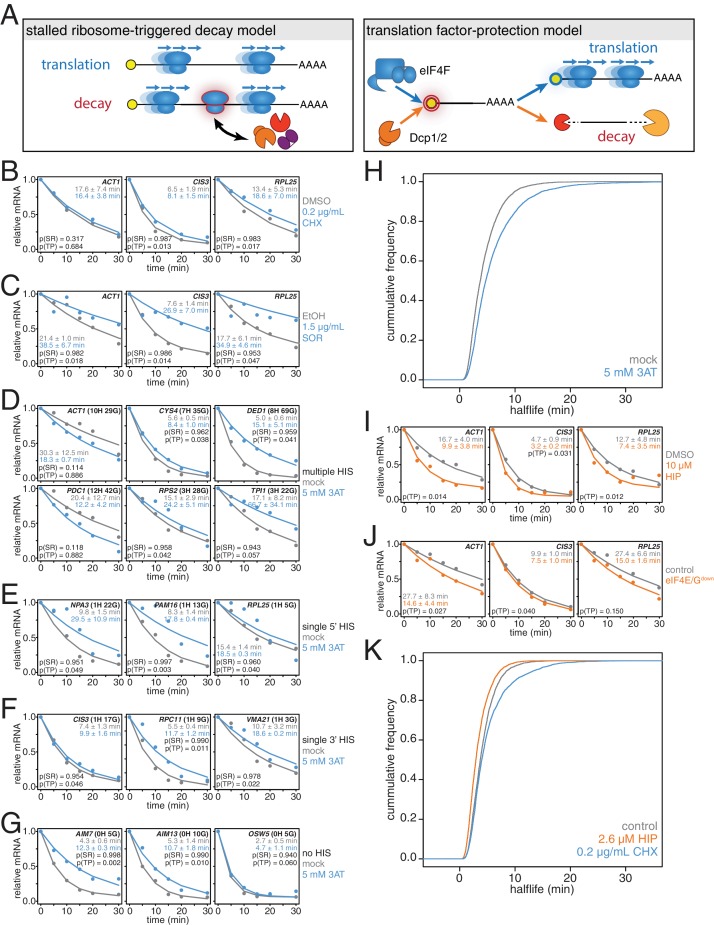
mRNAs are stabilized by slowly elongating ribosomes and destabilized when translation initiation is inhibited.(A) Cartoon depictions of the stalled ribosome-triggered decay and translation factor-protection models. (B) Wild-type cells (KWY165) were subjected to mRNA stability profiling immediately after addition of 0.1% DMSO or 0.2 μg/mL cycloheximide in 0.1% DMSO. Data on ACT1, CIS3 and RPL25 mRNAs were collected and plotted. See Figure 3—figure supplement 4A for biological replicates. P-values are computed using a one-sided paired t-test for both the stalled ribosome-triggered decay model (p(SR)) as well as the translation factor-protection model (p(TP)). P-values less than 0.05 are significant. (C) Wild-type cells (KWY165) were subjected to mRNA stability profiling 33 min after addition of 0.1% ethanol or 1.5 μg/mL sordarin in 0.1% ethanol (note that this is the timepoint when a growth defect is manifested, see Figure 3—figure supplement 1C). Data were collected, analyzed and plotted as in Figure 3B. See Figure 3—figure supplement 4B for biological replicates. (D–G) HIS3 gcn2∆ cells (KWY7337) were subjected to mRNA stability profiling immediately after non-addition (mock) or addition of 5 mM 3AT. Data were collected, analyzed and plotted as in Figure 3B. See Figure 3—figure supplement 4C for biological replicates. (H) mRNA samples collected from the experiment described in Figure 3D–G were subjected to global mRNA stability profiling. Cumulative frequencies of transcript half-life are plotted. (I) Wild-type cells (KWY165) were subjected to mRNA stability profiling immediately after addition of 0.1% DMSO or 10 μM hippuristanol. Data were collected, analyzed and plotted as in Figure 3B. p-values were not computed for the stalled ribosome-triggered decay model as this model does not make a clear prediction as to how mRNA stability is affected when translation initiation is perturbed. See Figure 3—figure supplement 5A for biological replicates. (J) pGPD1-LexA-EBD-B112 CDC33-3V5-IAA7 pRS425 cells (KWY7336: control) and pGPD1-LexA-EBD-B112 CDC33-3V5-IAA7 pGPD1-OsTIR1 pRS425-p4xLexOcyc1-CDC33∆CAP cells (KWY7334: eIF4E/Gdown) were grown in CSM-LEU-0.5xURA pH5.5 media and subjected to mRNA stability profiling immediately after addition of 10 nM β-estradiol, 100 μM 3-indoleacetic acid and 4 μM IP6. Data were collected, analyzed and plotted as in Figure 3I. See Figure 3—figure supplement 5B for biological replicates. (K) Wild-type cells (KWY165) were subjected to global mRNA stability profiling immediately after addition of 0.1% DMSO (gray) or 2.6 μM hippuristanol (orange) or 0.2 μg/mL cycloheximide (blue). Cumulative frequencies of transcript half-life are plotted.10.7554/eLife.32536.014Figure 3—source data 1.Source data for Figure 3B, C, D–G, I and J: decay kinetics of selected mRNAs in cells treated with translational inhibitors.10.7554/eLife.32536.015Figure 3—source data 2.Source data for Figure 3H: Transcriptome wide decay data for cells treated or mock treated with 3AT.10.7554/eLife.32536.016Figure 3—source data 3.Source data for Figure 3K: Transcriptome wide decay data for cells treated with DMSO, cycloheximide or hippuristanol.